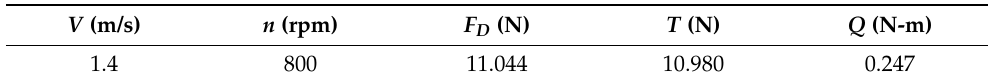
Table 3. Calculation results of the self-propulsion state for the hybrid-driven AUG with the single propeller.